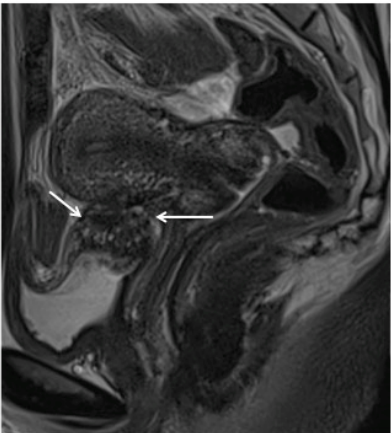
Figure 5. Magnetic resonance imaging depiction of bladder deep endometriosis. Sagittal T2-weighted plane depicting deep endometriosis nodule in hyposignalT2, which is infiltrating the detrusor muscle of the bladder (white thin arrows).